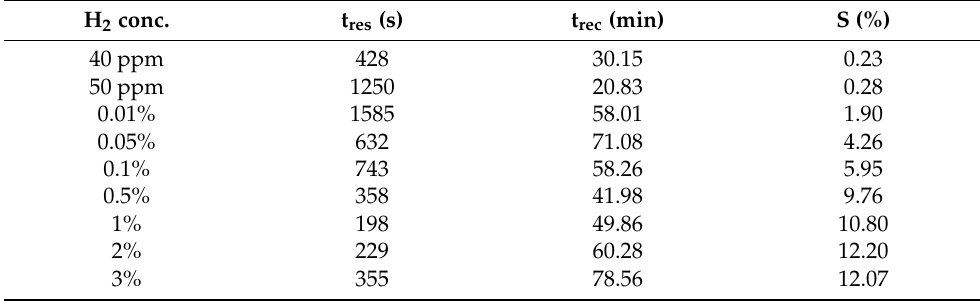
Figure 4. ( a ) I/V characteristic curve of the sensor in air; ( b ) Sensing response at different hydrogen concentrations (0.1–3%); ( c ) Detection limit of hydrogen concentration; ( d ) Sensitivity of sensor at different hydrogen concentrations. The on and off symbols in the figures indicated that the hydrogen flow was turned on and off respectively. Table 1. The sensor response time (t res ), recovery time (t rec ) and sensitivity (S) of the sensor toward different concentrations of hydrogen (H 2 conc.).